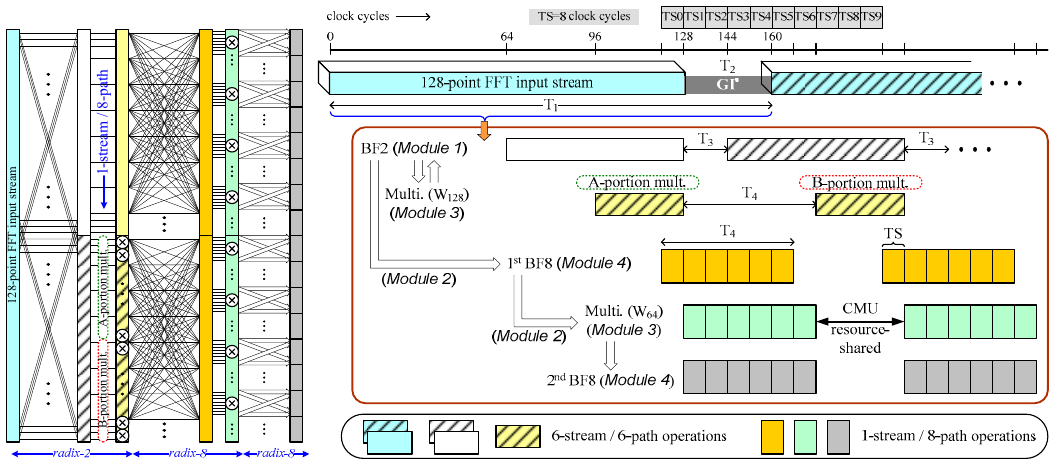
Figure 8. Detailed timeliness diagram for operations of the proposed MRM 2 DF-structured FFT kernel and its associated signal flow chart for the radix-2/8/8 algorithm.